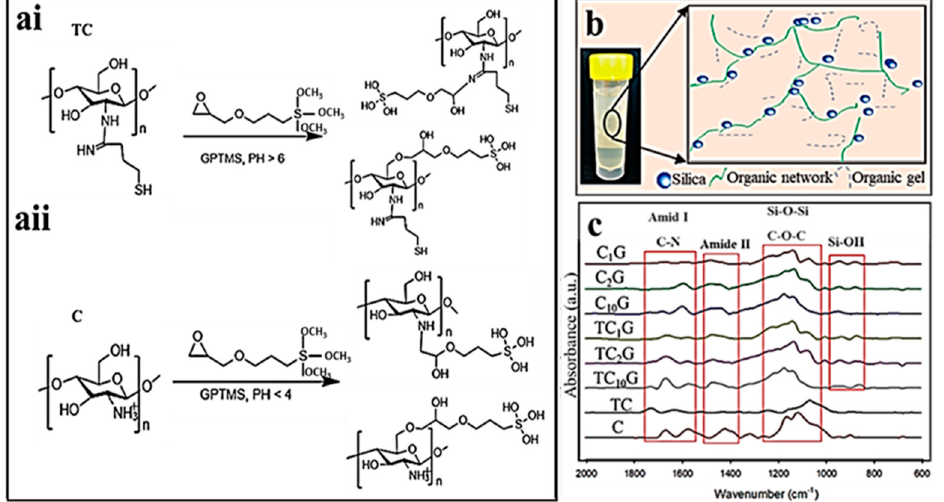
Figure 1. ( a ) Schematic showing the reaction sequences and the chemical structures of thiolated chitosan ( ai ) and chitosan ( aii ) needed for hydrogel preparation. ( b ) A schematic image of the distribution of globular particles of the branched 3D network of silica and chitosan on the hybrid hydrogel. ( c ) FTIR spectra of hybrid hydrogels with varying organic/inorganic weight ratios showing amide I and II, Si-O-Si and Si-ONB bands. 1 H NMR spectra (Figure 2) for chitosan revealed peaks between 3.0 and 5.0 ppm,